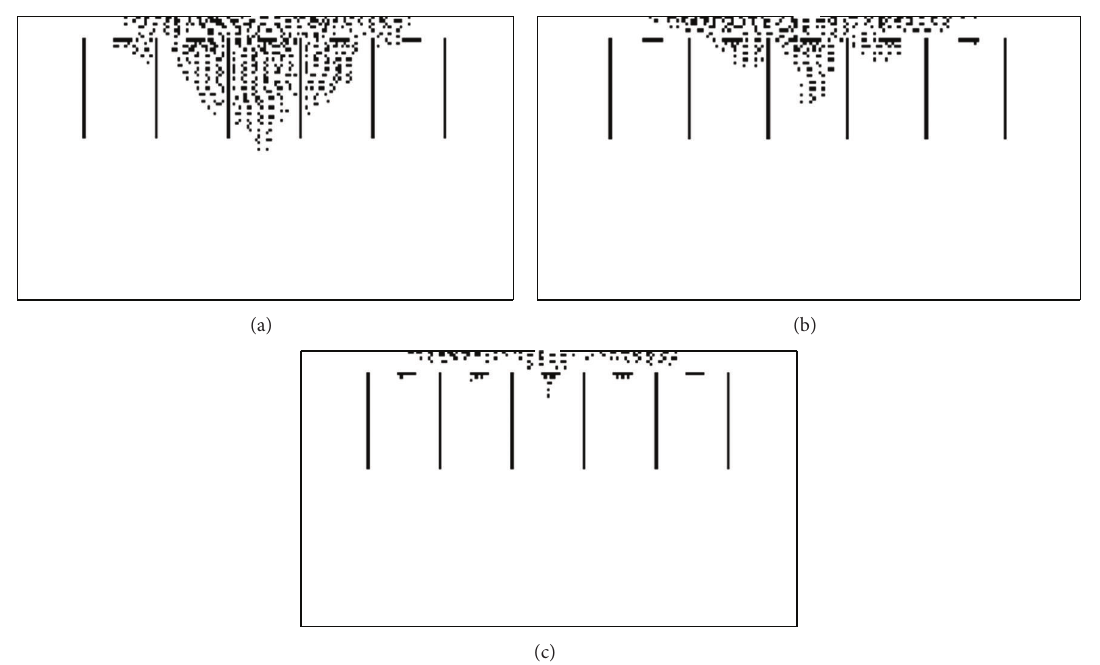
Figure 5: The simulation of evacuation process for a stadium setting the isolated belts.